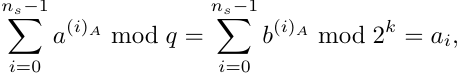
Algorithm 1 Masked version of Compress Kyber for any order using one A2B conversion per